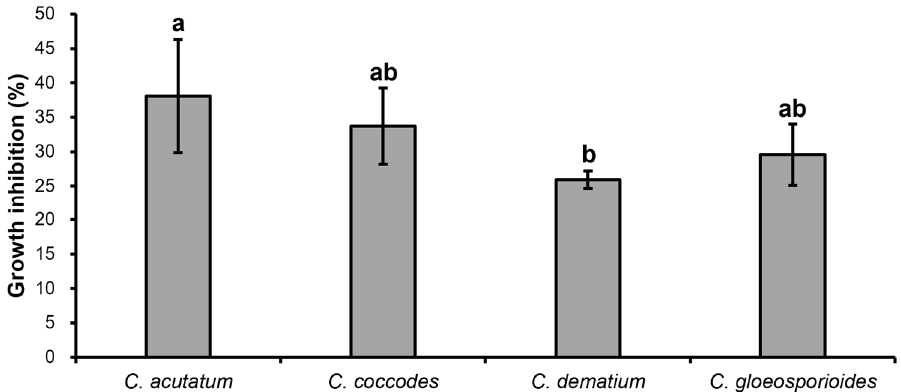
Figure 3. Inhibition of mycelial growth of various Colletotrichum species by volatile organic com- pounds of B. velezensis CE 100. Histograms represent the mean ± standard deviation of three replications. Different letters represent significant differences (LSD test, p < 0.05).